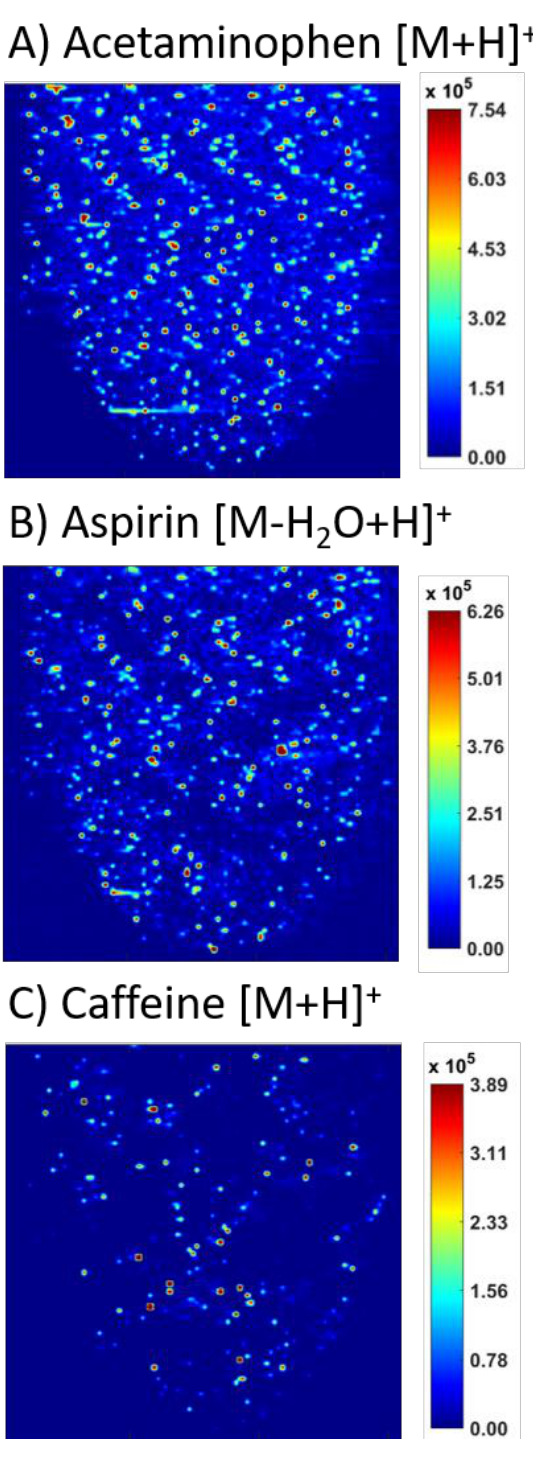
Figure 4. MS images of the three APIs in brand “B” over the counter tablets, including ( A ) acetaminophen, ( B ) aspirin, and ( C ) caffeine.